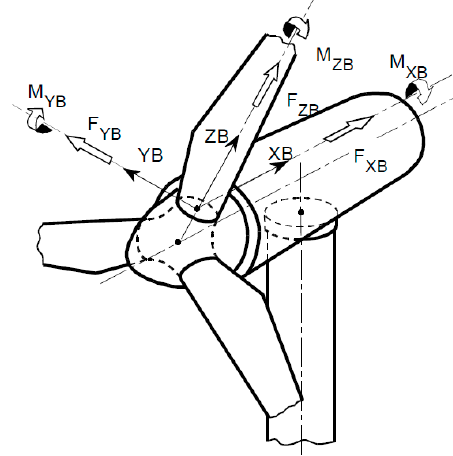
Figure 6. Blade coordinate system; XB in direction of the rotor axis, ZB in radial direction along the blade, and YB in direction of the cross product of ZB and XB [4].